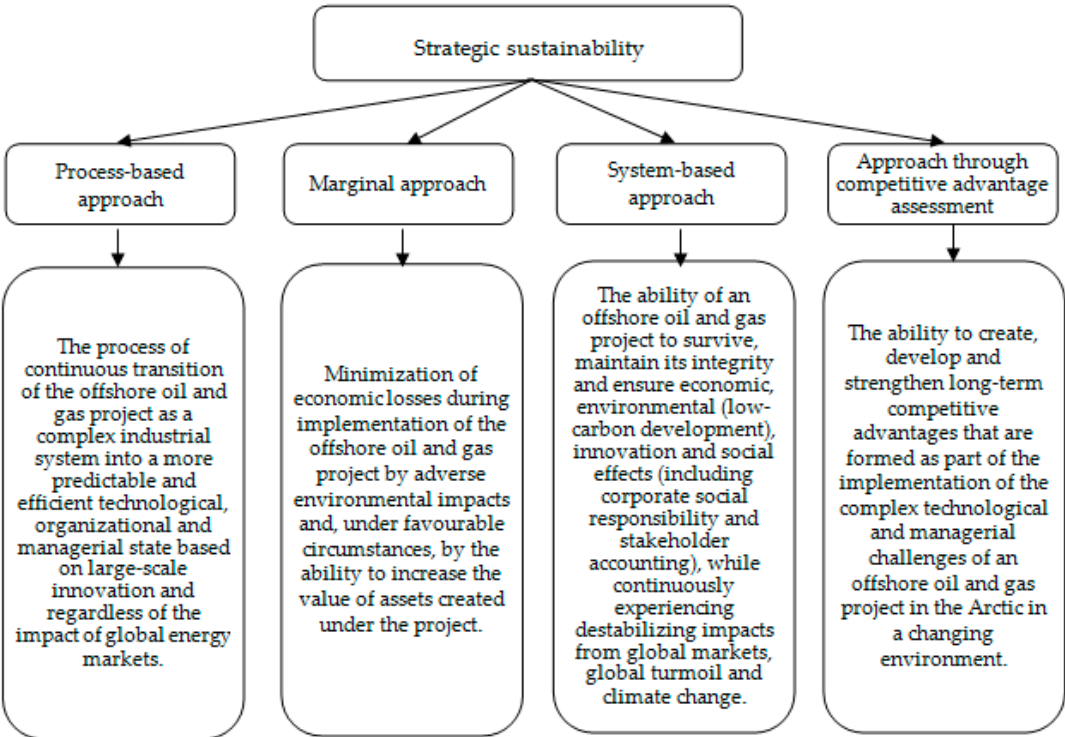
Figure 1. Classification of approaches to the definition of “strategic sustainability” of the offshore Arctic oil and gas project. Source: authors self-elaboration.